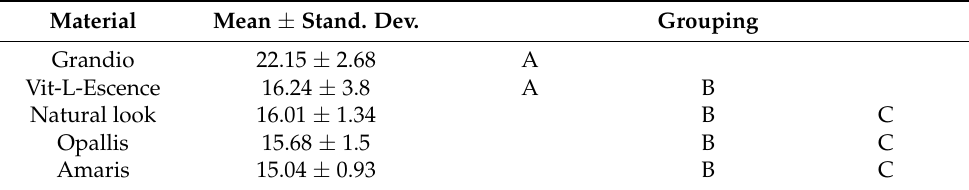
Table 5. Mean and standard deviation for the elastic modulus (GPa) measurement according to the factor resin composite material. Same Capital Letter(s) means no statistical difference among groups ( α =